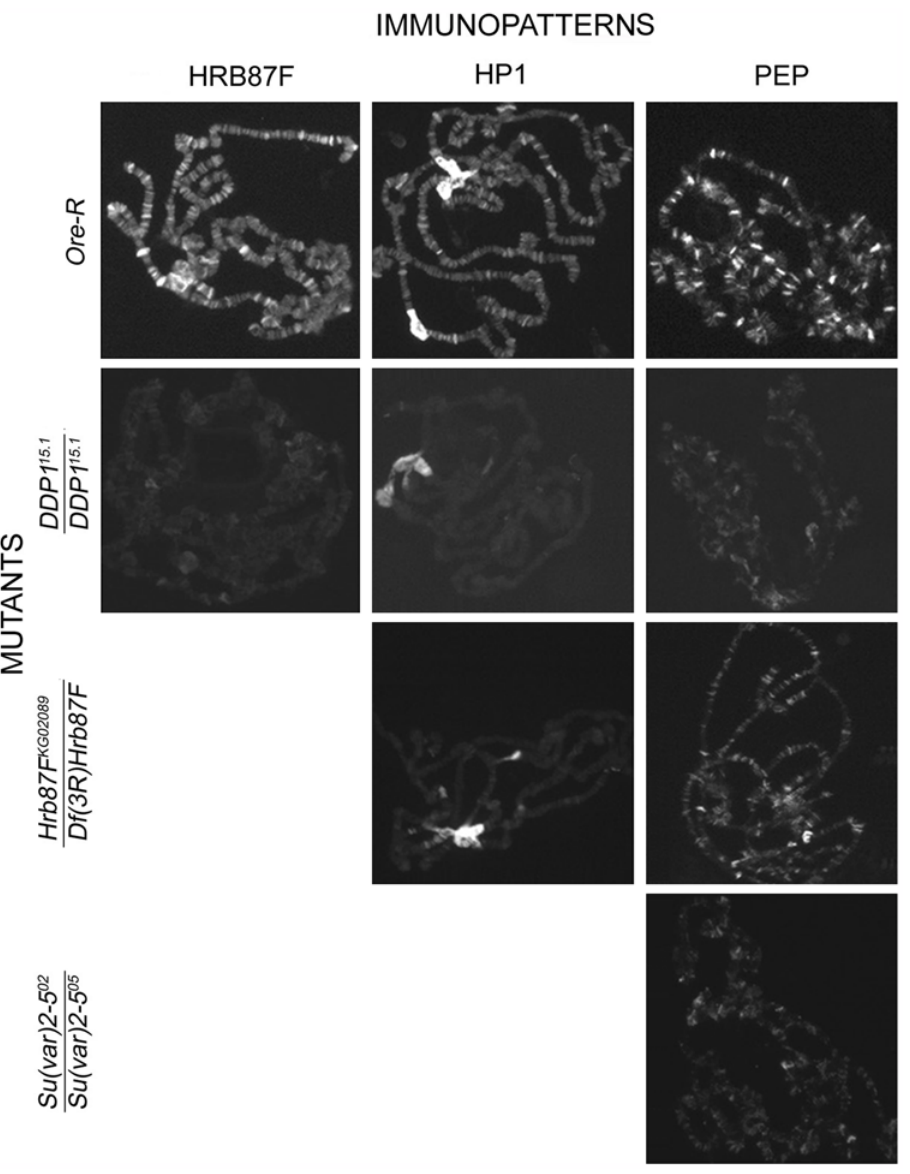
Figure 5. Hierarchical dependence of HP1a, DDP1, HRB87F, and PEP in their assembly on RNA transcripts. Immunopatterns of each protein on polytene chromosomes of wild type larvae and larvae mutant for the genes encoding each of the other proteins. (Only the abnormal patterns are reported here; a complete version of the results is in Figure S3). In DDP1 mutants, the immunopatterns of the other proteins are abnormal. In Hrb87F mutants, the HP1a and PEP immunopatterns are abnormal while the DDP1 immunopattern is unaltered. In HP1a mutants only the PEP immunopattern is abnormal, whereas in PEP mutants the immunopatterns of all other proteins are normal (see Figure S3).